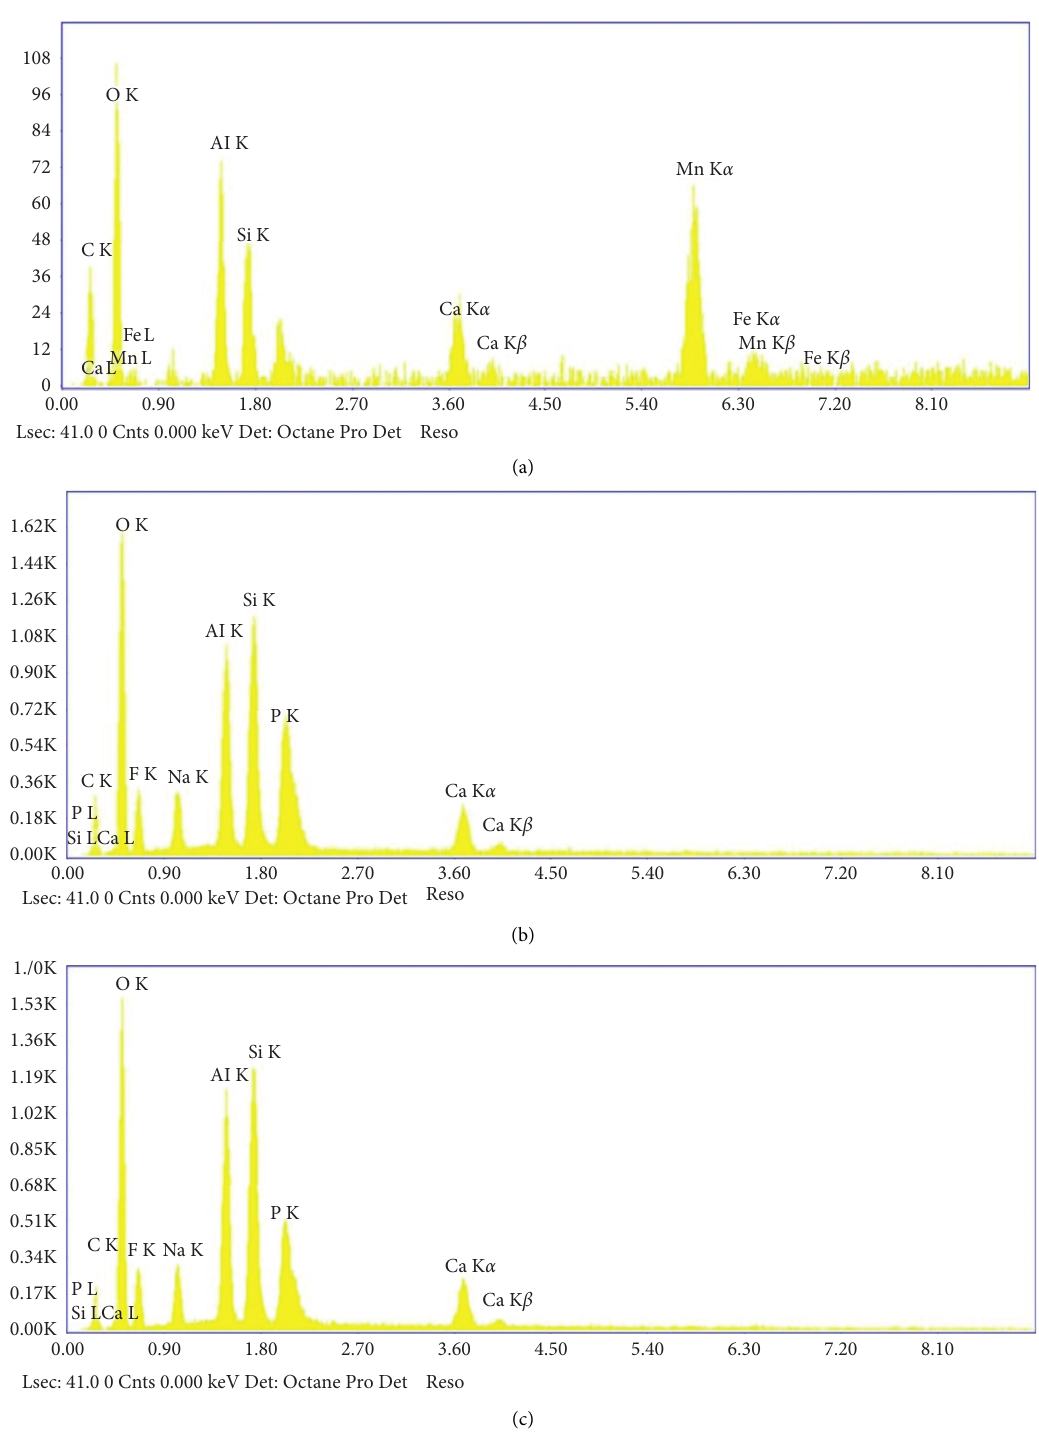
Figure 4: EDX analysis of the main Amalgomer CR specimens before and after addition of different volume proportions of propolis. (a) Amalgomer CR. (b) Amalgomer CR with 25 v/v % propolis. (c) Amalgomer CR with 50 v/v %